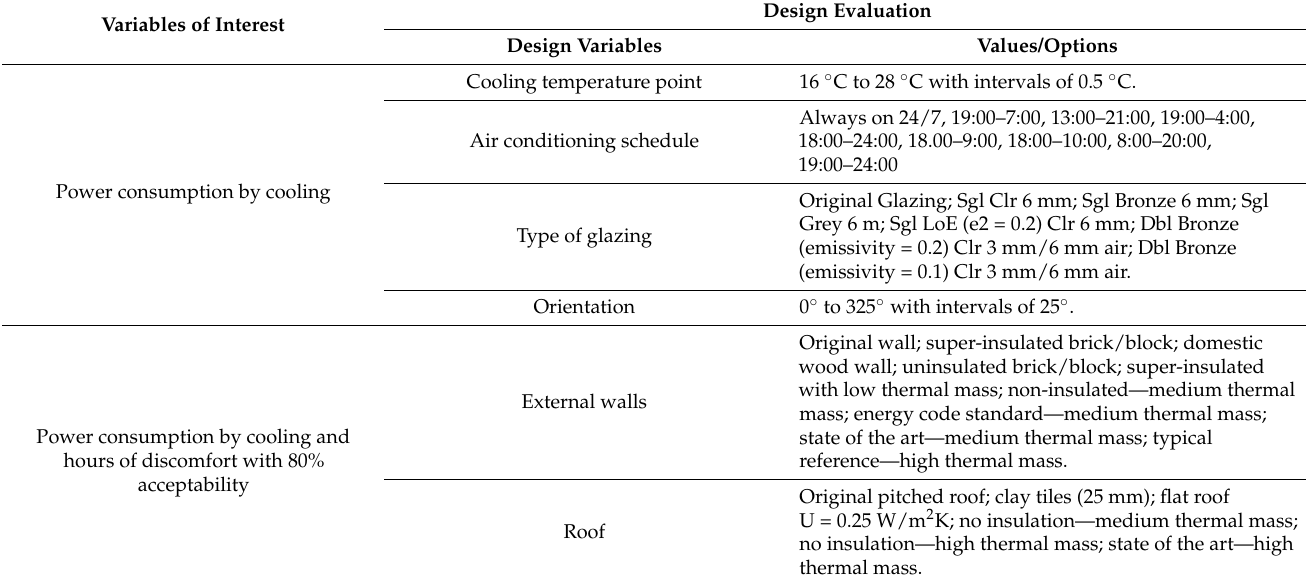
Table 3. Variables of interest, design variables, and options evaluated in the parametric